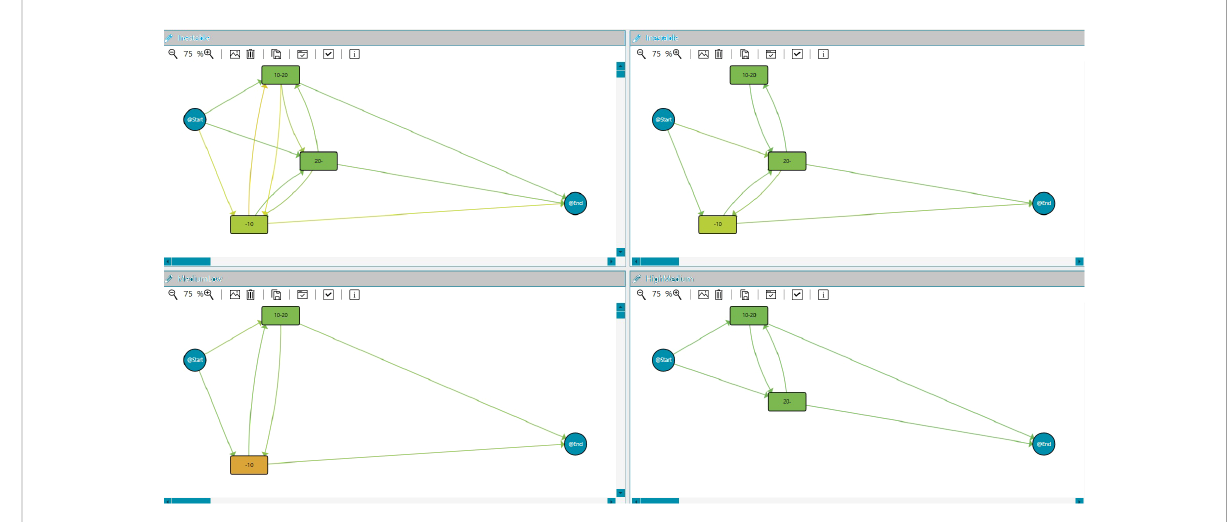
FIGURE 7 Clustering. IPI showing the clustering models for PSA evolution during the study duration: PSA unstable evolution, PSA low to medium, and PSA